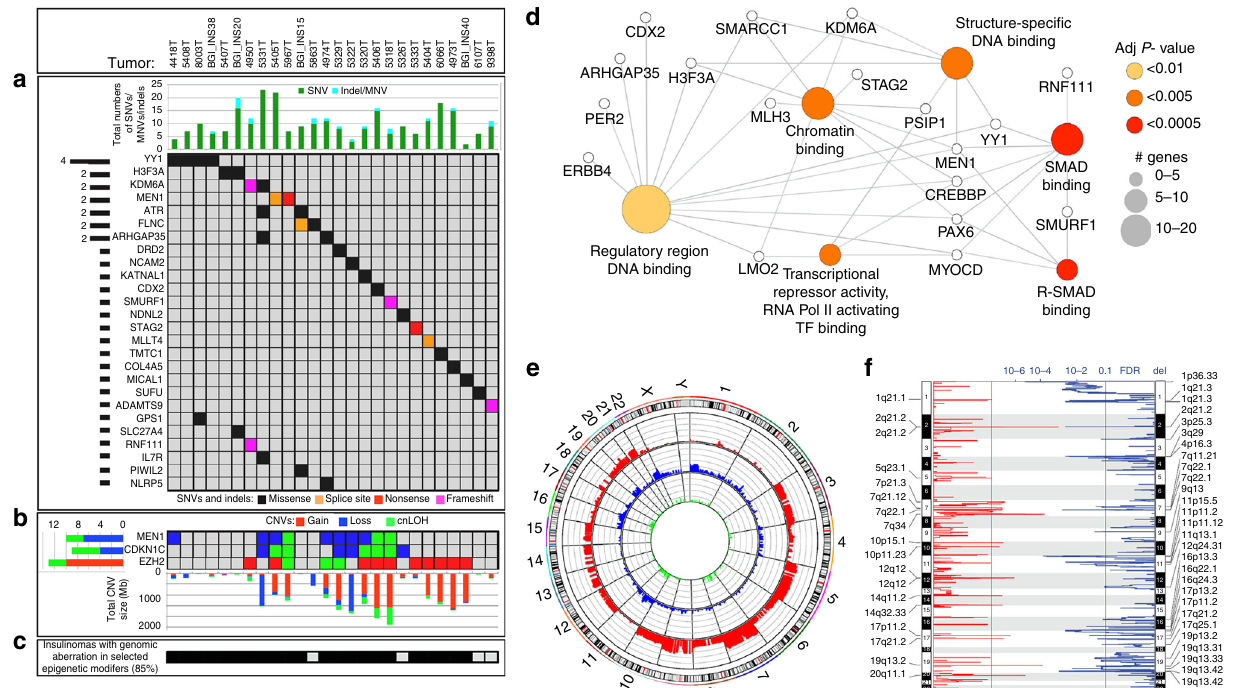
Fig. 1 Global molecular characterization of the insulinoma genomic landscape from whole-exome sequencing data. a A summary of 26 insulinomas ( top box ) and a subset of their protein-changing key driver variants, each sample displaying the variant with the highest allelic fraction and, if any, the variant from recurrently mutated genes. All variants are somatic, except for a germline MEN1 variant from sample 5967T (at chr11:64,572,613, G > A, p.R420*, nonsense). b A summary of somatic copy number variants from selected model-predicted epigenetic modi fi ers and CDKN1C . c A summary showing which 85% of insulinomas harbor mutations or CNVs in selected epigenetic modi fi ers. d GO pathway analysis (Molecular Function) of insulinoma key driver variants reveals terms associated with chromatin-binding and SMAD signaling as the most prominent pathways. e Circos plot of copy number gain ( red ), loss ( blue ), or copy-neutral cnLOH ( green ). Each line within a track represents 20% of the total number of insulinomas. Note that ~ 20% of insulinomas have CNV loss on chromosome 11 ( blue ), and ~ 20 – 40% have CNV gain on chromosome 7 ( red ). f GISTIC2.0 analysis showing fi ner mapping of regions of signi fi cant chromosomal ampli fi cation or deletion throughout the genome. Cytoband labels indicate signi fi cant calls (FDR <